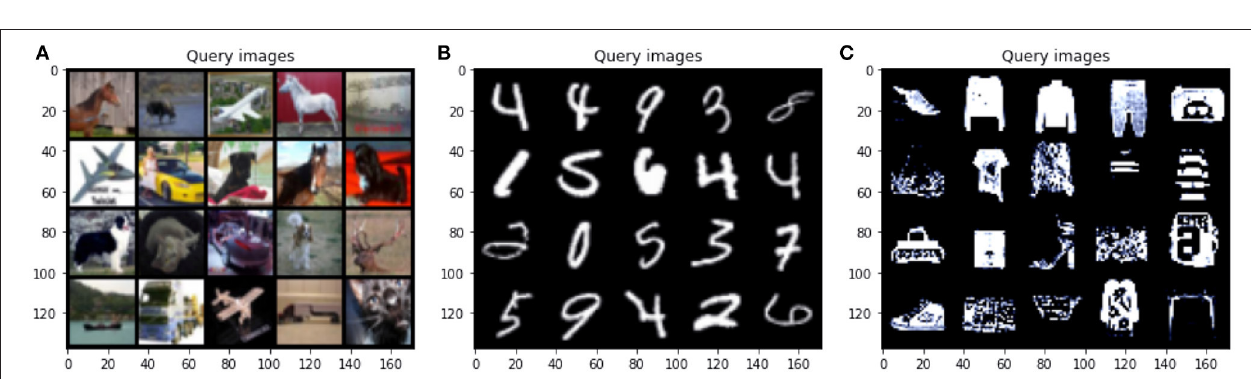
FIGURE 8 | ( A , left) Top 25 query images for CIFAR-10 selected in the first round of active learning using a budget( b ) of 1,000 and model M 2 . ( B , middle) Query images for MNIST and ( C , right) FashionMNIST using a budget( b ) of 100 and model M 1 .